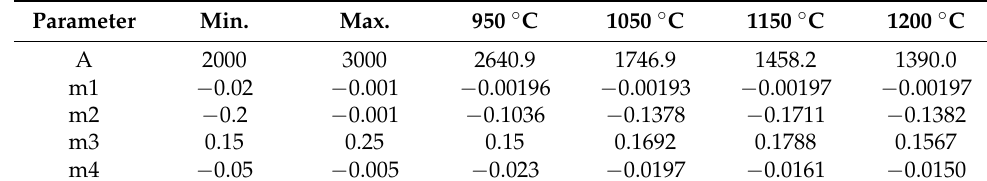
Figure 9. Changes in cost function and parameters during optimization: ( a ) cost function, ( b ) A, ( c )